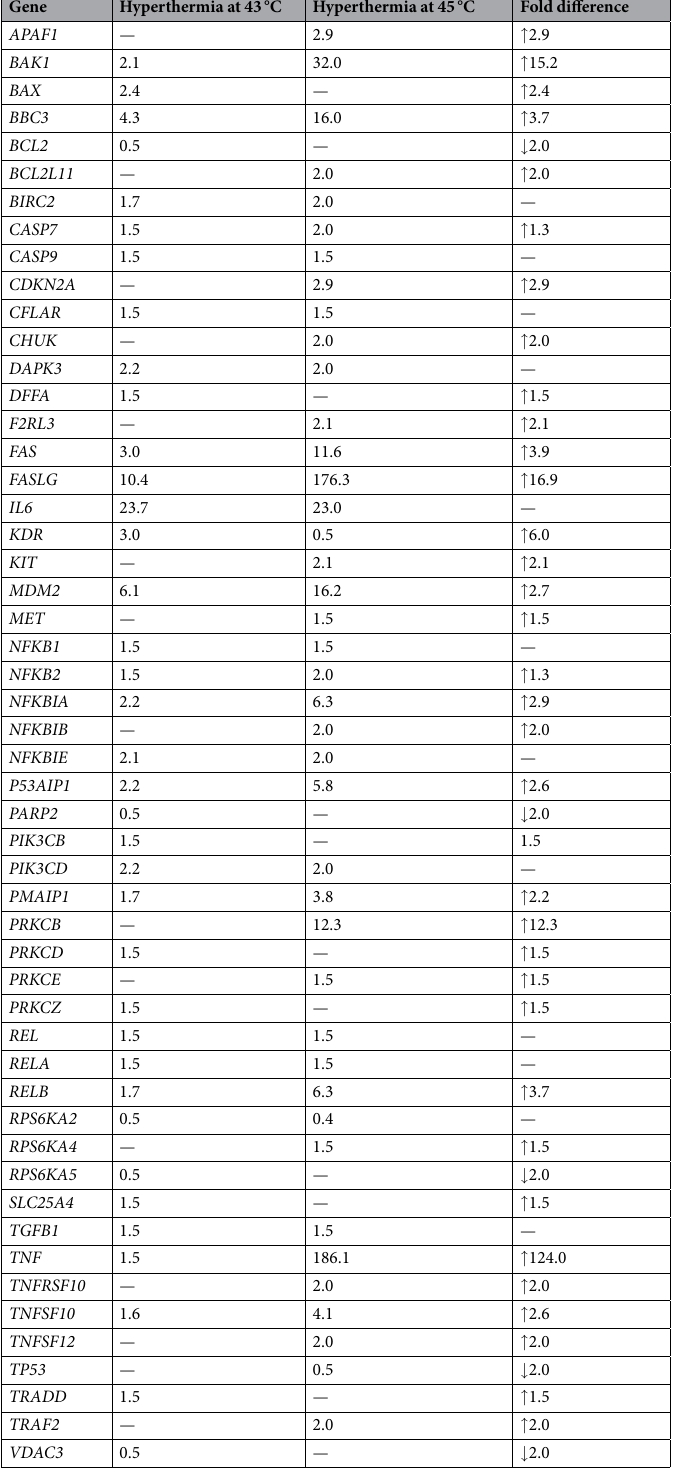
Table 1. Expression levels of apoptotic genes in A375 cells at 24 h post-exposure to 43 °C and 45 °C hyperthermia. Data, from each hyperthermic condition (43 °C or 45 °C), are expressed as fold increase in comparison to control (37 °C) (1 st and 2 nd column) while expressed as fold difference when comparing the two hyperthermic exposure conditions (43 °C and 45 °C) with each other (3 rd column). Gene expression data were analyzed by the ΔΔ Ct method and differences observed were expressed as fold change in gene expression by using the DataAssist v3.01 software. ( ↑ ) denotes up-regulation whereas ( ↓ ) down-regulation and ( − ) no significant fold change between hyperthermic conditions (43 °C or 45°C) compared to control (37°C). Data shown are mean values from two independent